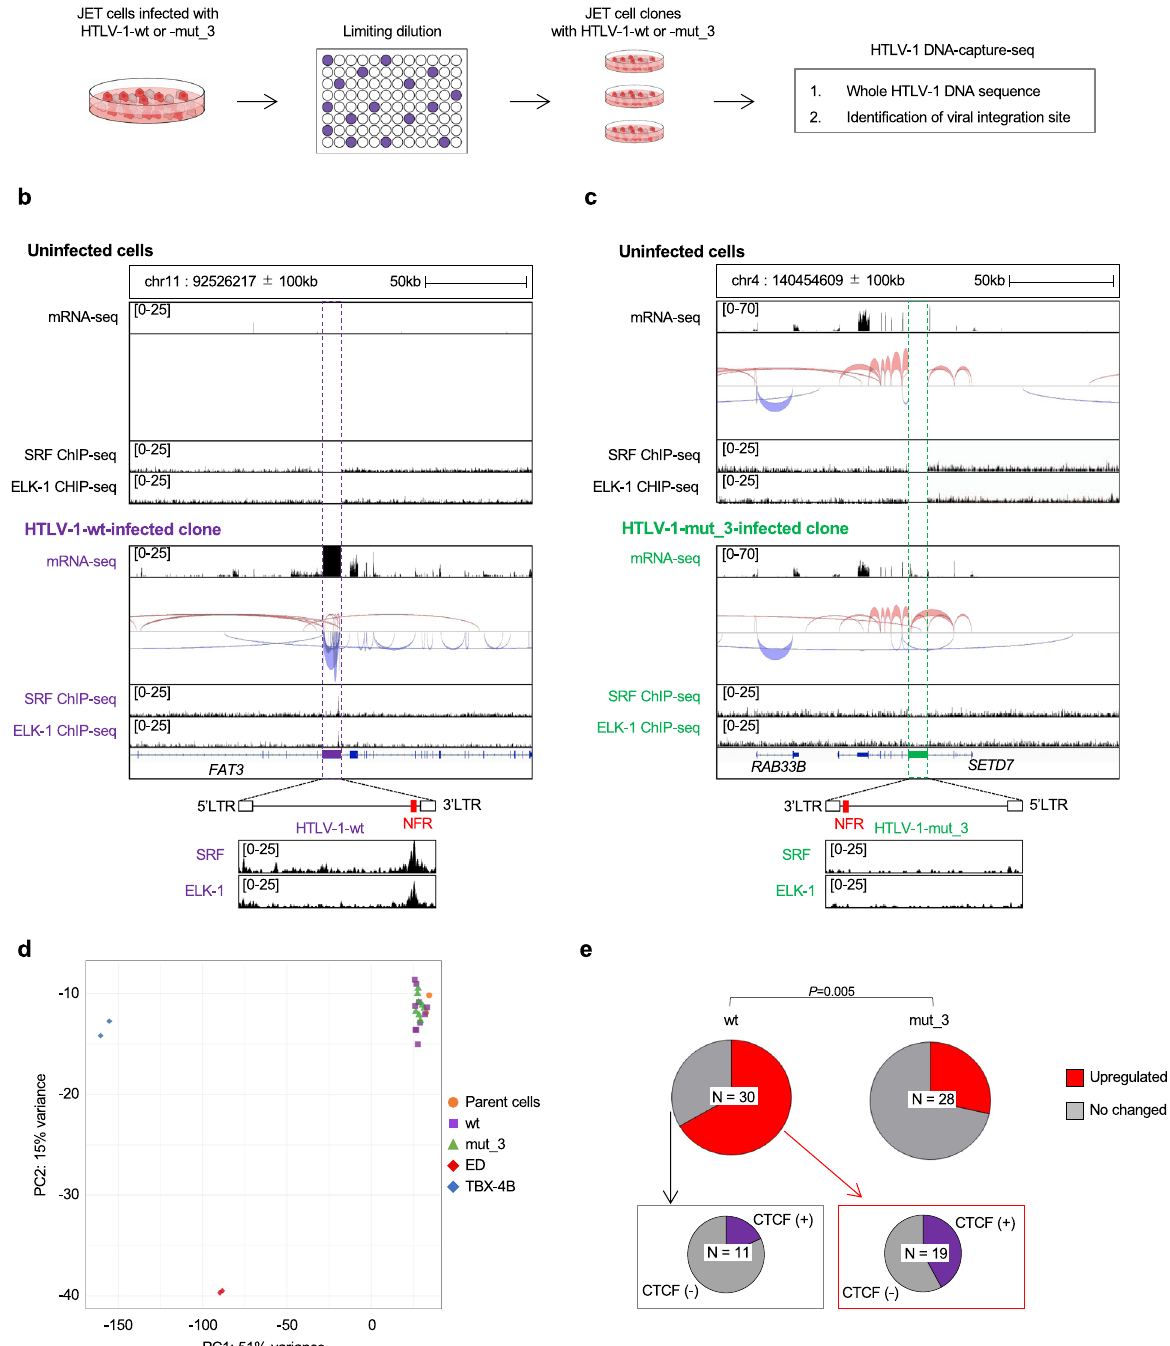
Fig. 5 Establishment and characterization of JET cell clones infected with HTLV-1-wt and mut_3. a Experimental work fl ow to establish clones infected with HTLV-1-wt or mut_3 by limiting dilution. b , c Local transcriptome and splice junction near the viral integration site in a JET clone infected with b HTLV- 1-wt (wt_#1) and c mut_3 (mut_3_#1) are visualized by IGV. The splice junctions are shown in red for sense transcripts and blue for antisense transcripts. The line thickness indicates the frequency of speci fi c splice patterns detected. Host genes near the IS and direction of HTLV-1 provirus are shown in the lower panel. SRF/ELK-1 ChIP-seq results are also shown for each clone in the bottom row. d Differential expression analysis in cell lines (ED and TBX-4B), parent cells (JET), wild type, and mutated clones (see Supplementary Table 2) visualized by principal component analysis (PCA) plot. Gene expression levels of each cell were quanti fi ed using mRNA-seq data performed in duplicates. The percentage variance for each PC were shown on the respective PC axis. e The fraction of upregulated genes in JET clones infected with HTLV-1-wt (left pie) and mut_3 (right pie). The analysis was performed with genes within 100 kb from viral IS. The presence or absence of CTCF ChIP-seq signals in the upregulated group (bottom left) or “ no change ” group (bottom right) of JET clones infected with HTLV-1-wt. P value was calculated by a two-sided Chi-square